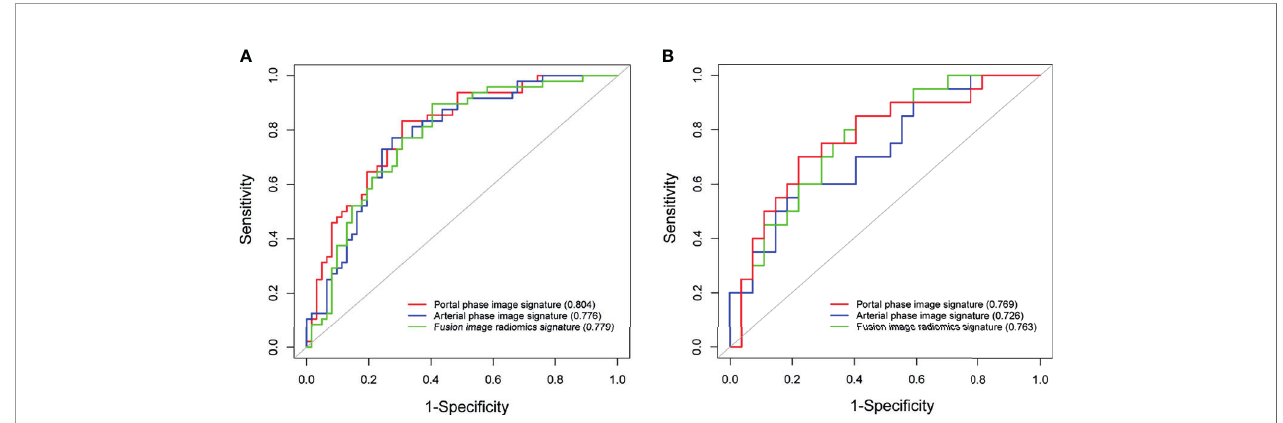
FIGURE 3 | Predictive performance of radiomic signatures for microvascular invasion. ROC curves of radiomic signatures in the training dataset (A) . ROC curves of radiomic signatures in the test dataset (B) .